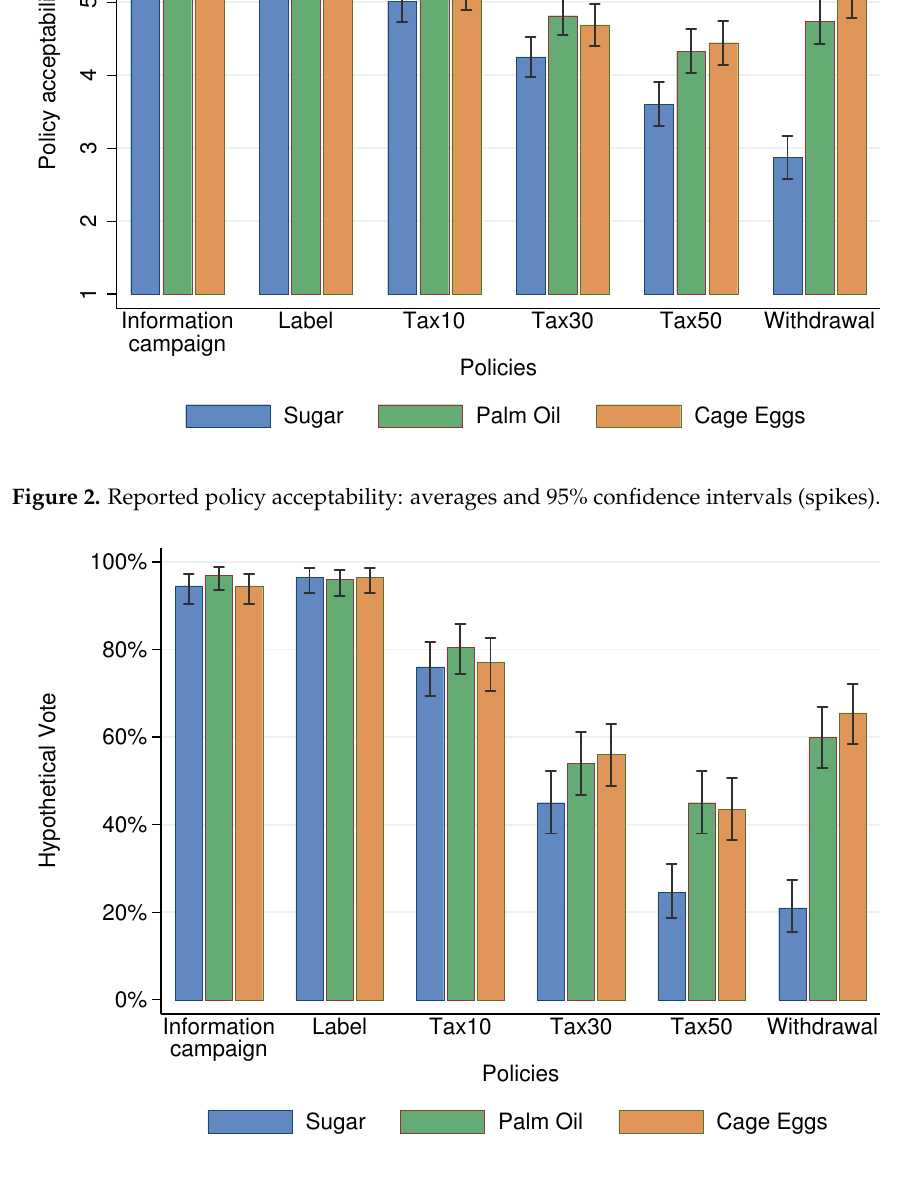
Figure 3. Hypothetical votes: averages and 95% confidence intervals